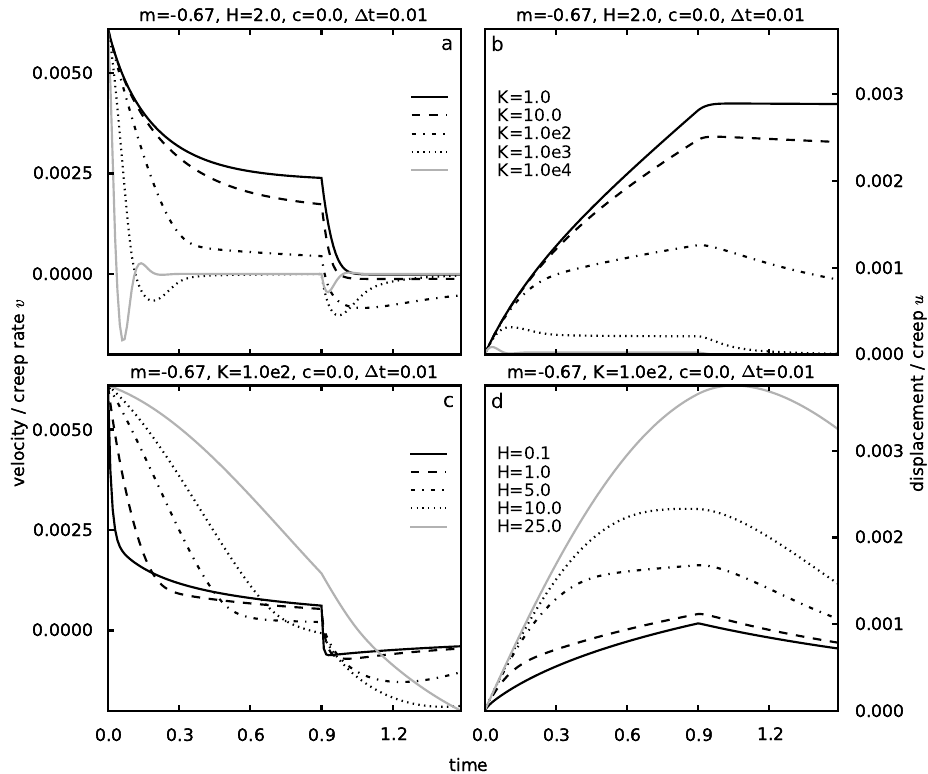
Fig. 3. (a, c) Velocity (creep rate) v at the slab surface as function of time. (b, d) Displacement (creep) u at the slab surface as function of time. In (a, b) solutions of v and u are displayed for H = 2 and variable K , while in (c, d) solutions of v and u are shown for K = 10 2 and different values of H . Other parameters are as displayed in the plot headers. All fields ( u , v , t ) are non-dimensional.